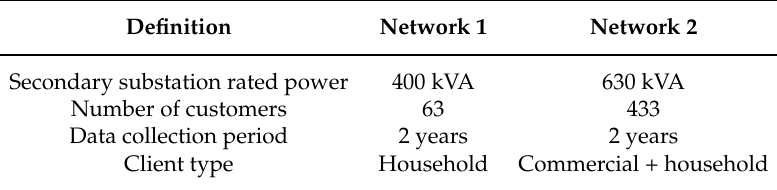
Table 1. Network characteristics.